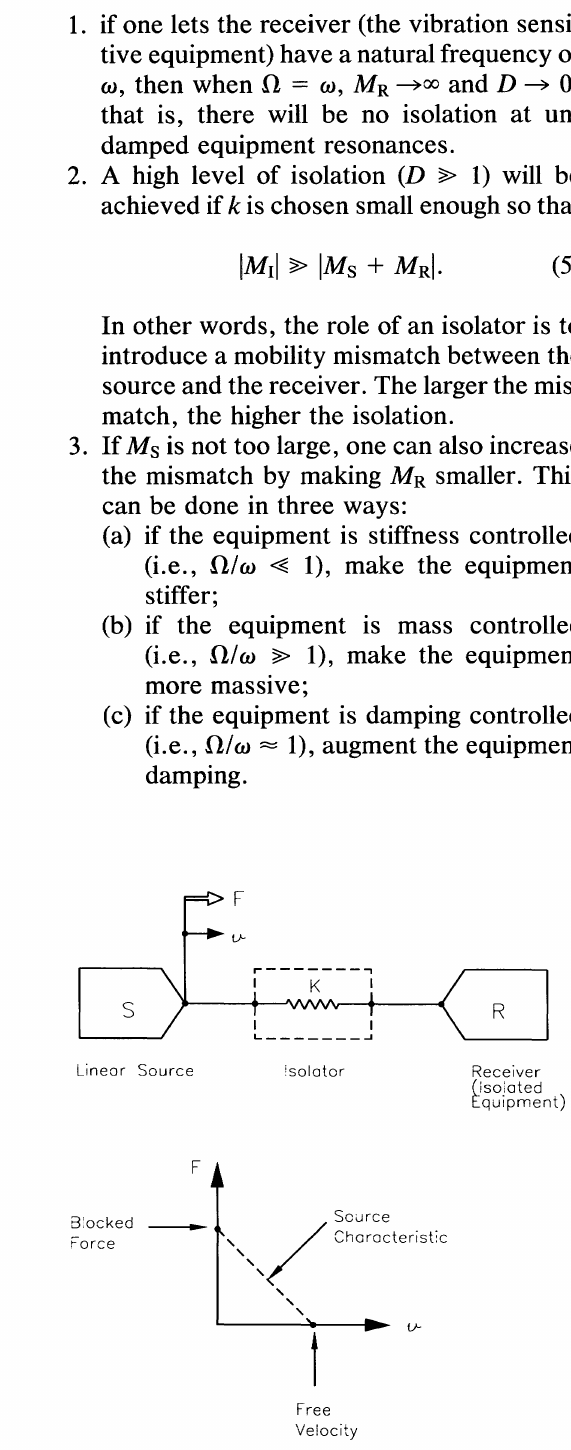
FIGURE 9 Schematic of a linear source (S) driving a piece of equipment (R) through a massless isolator